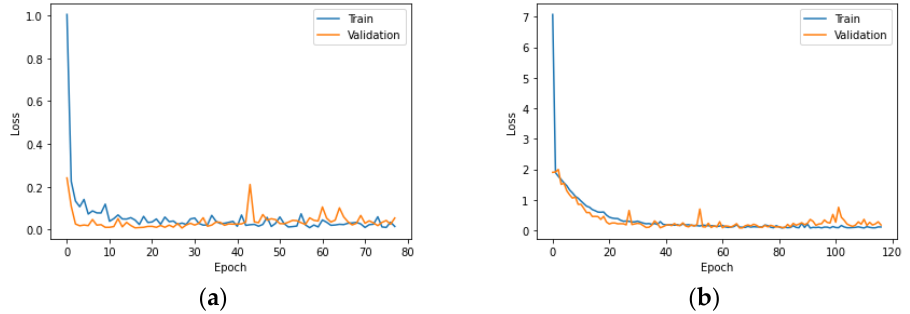
Figure 11. Learning curves of CNN models for ( a ) synchronization and ( b ) data decoding.